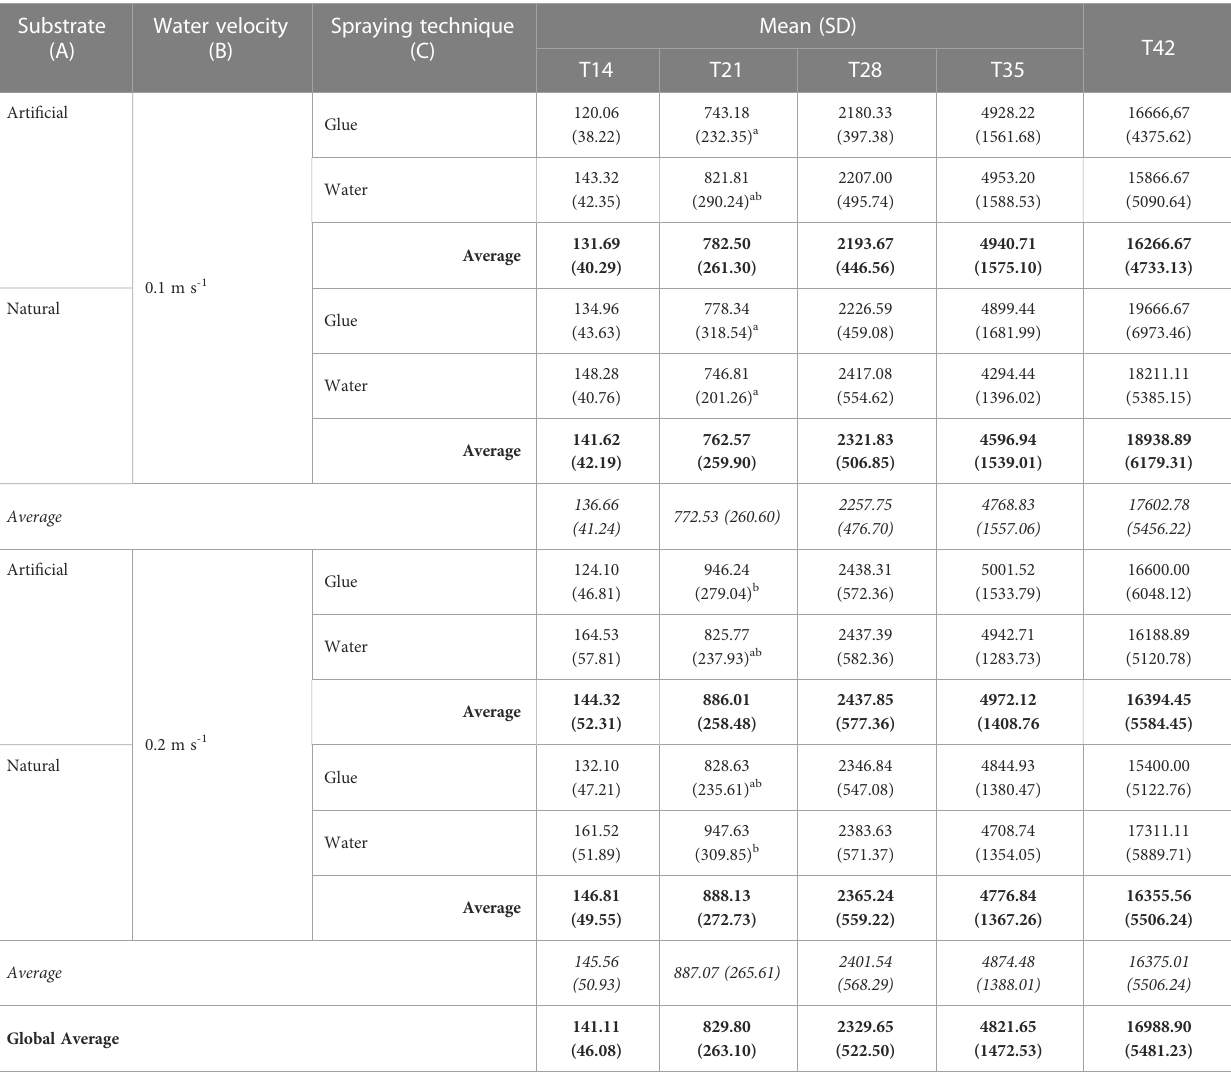
TABLE 2 Seedlings length (µm) of S. latissima (means ± SD) according to substrate (Natural or Arti fi cial, A), water velocity (0.1 m s -1 or 0.2 m s -1 , B), and spraying technique (water vs. binder, C) at day 14, 21, 28 and 35 of the experiment.